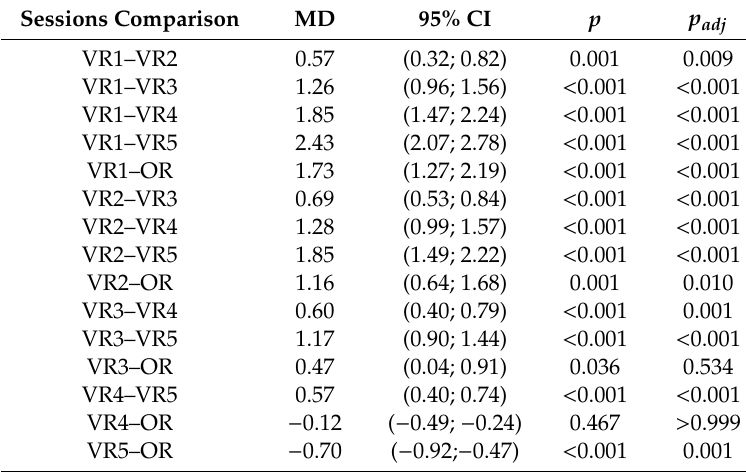
Table 2. TBC change between sessions (MANOVA post-hoc test; MD—mean di ff erence in TBC between two sessions calculated as the later session mean minus the previous session mean, with a 95% confidence interval (CI); p –individual paired t-test p -value; p adj –paired t-test p -value adjusted for multiple comparisons (Bonferroni correction)). Sessions